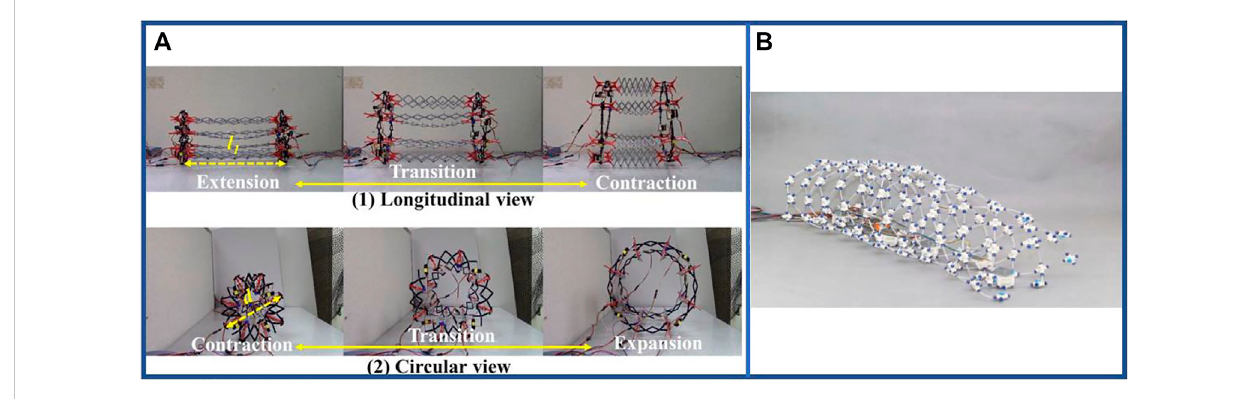
FIGURE 13 Examples of electric-driven multi-segment earthworm-inspired soft robots with continuous deformable structures. (A) Design and deformation of earthworm-likelocomotion robot (Luo et al., 2022). Reproduced from Ref. (Luo et al., 2022). with permission. (B) Prototype of worm robot controlled by central pattern generator (Wang et al., 2018b). Reproduced from Ref. (Wang et al., 2018b). with permission.